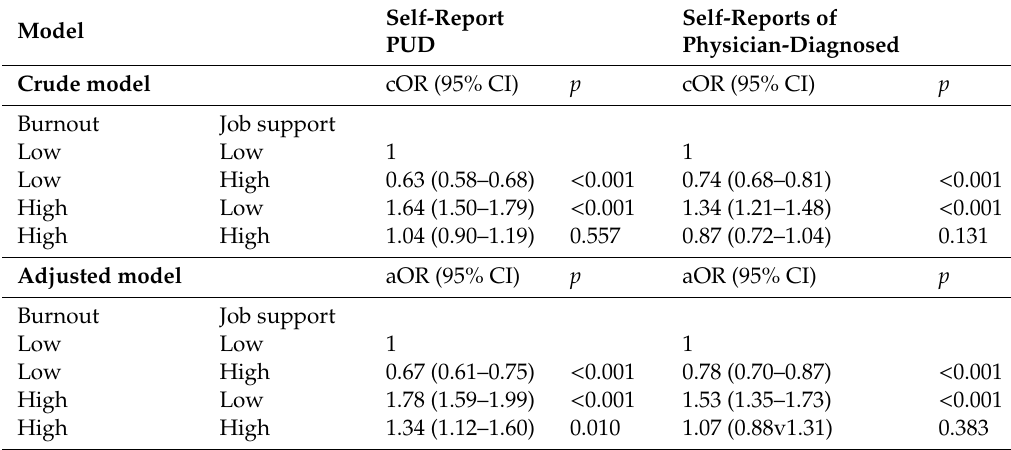
Table 5. Interaction between burnout and job support on the prevalence of peptic ulcer diseases (PUD) reported by participants and self-reported diagnosed by physicians using multiple logistic regression adjusted for groups, educational level, marital status, duration of job, levels of employing government, position of superior, alcohol drinking, smoking and betel nut